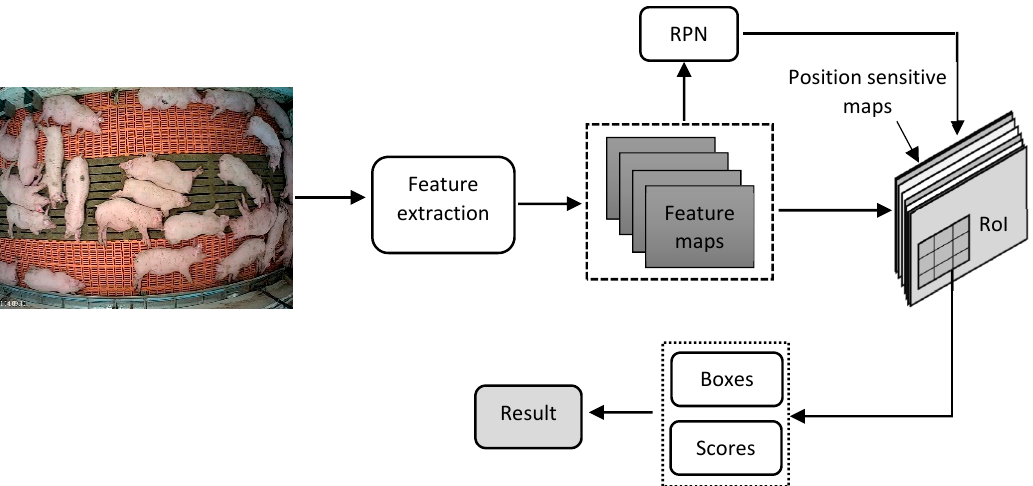
Figure 4. Schematic diagram of the region-based fully convolutional network (R-FCN) used in this study.